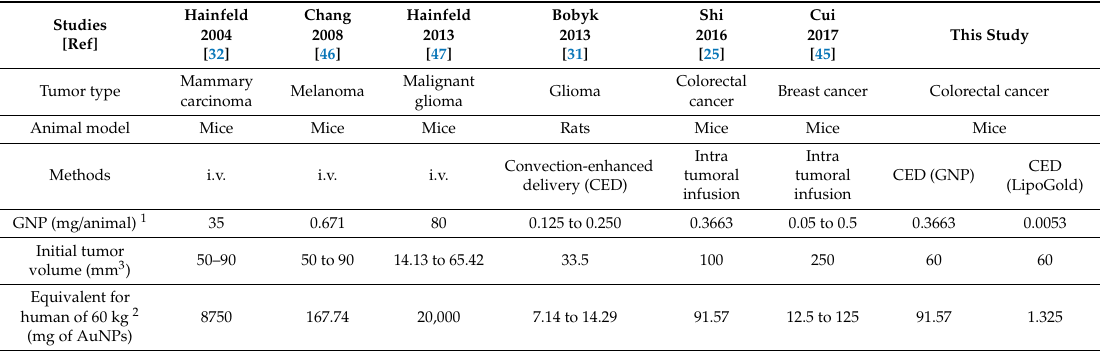
Table 1. Comparison of key publications using gold nanoparticles (GNPs) for cancer treatment studies in relation to injected concentrations of